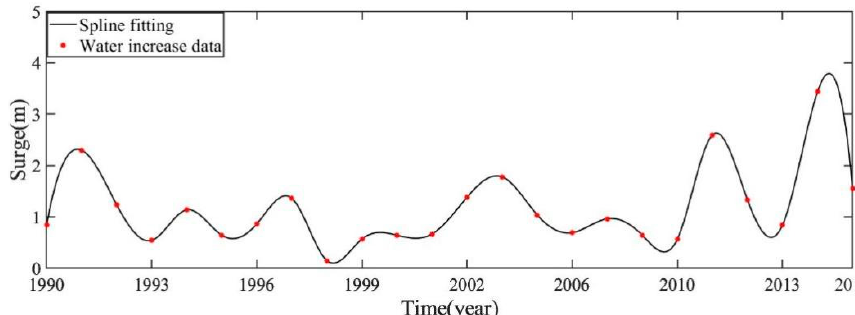
Figure 4. The water increase data scatter plot when Δ𝑡 = 12 .